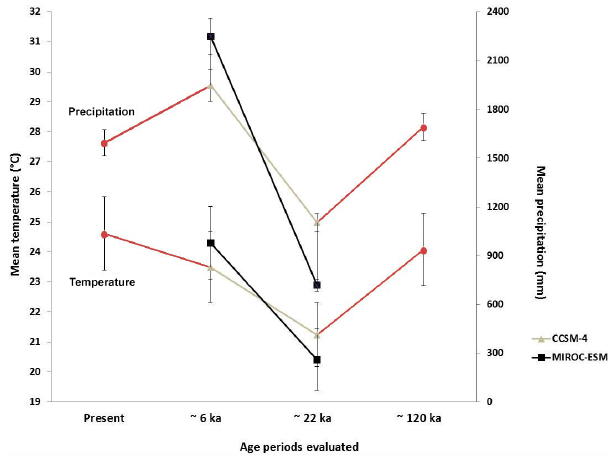
Figure 2. Estimated mean annual temperature and mean annual precipitation values for ∼ 120, ∼ 22 and ∼ 6ka and present. Esti- mates for ∼ 22 and ∼ 6ka were based on general circulation models CCSM4 (grey line) and MIROC-ESM (black